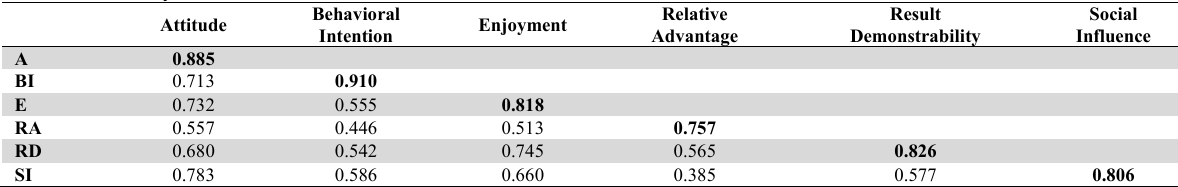
Results of validity test